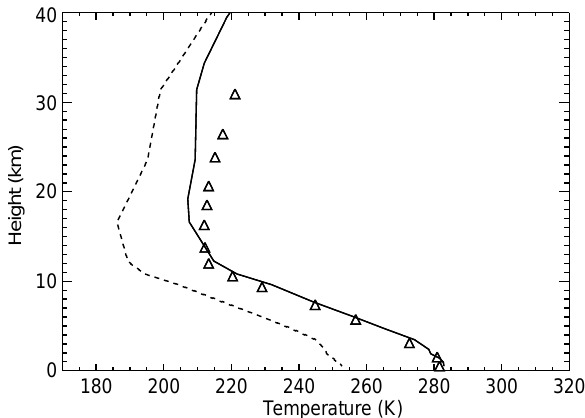
Fig. 8. As in Fig. 1., but for October conditions